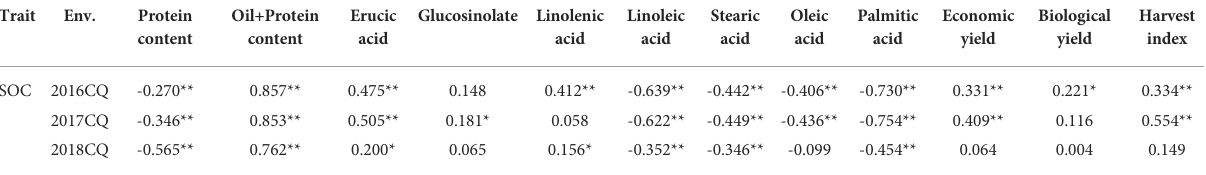
TABLE 2 Correlation coef fi cients of seed oil content (SOC) with 12 other traits in a B. napus RIL population grown in different environments. Trait Env.